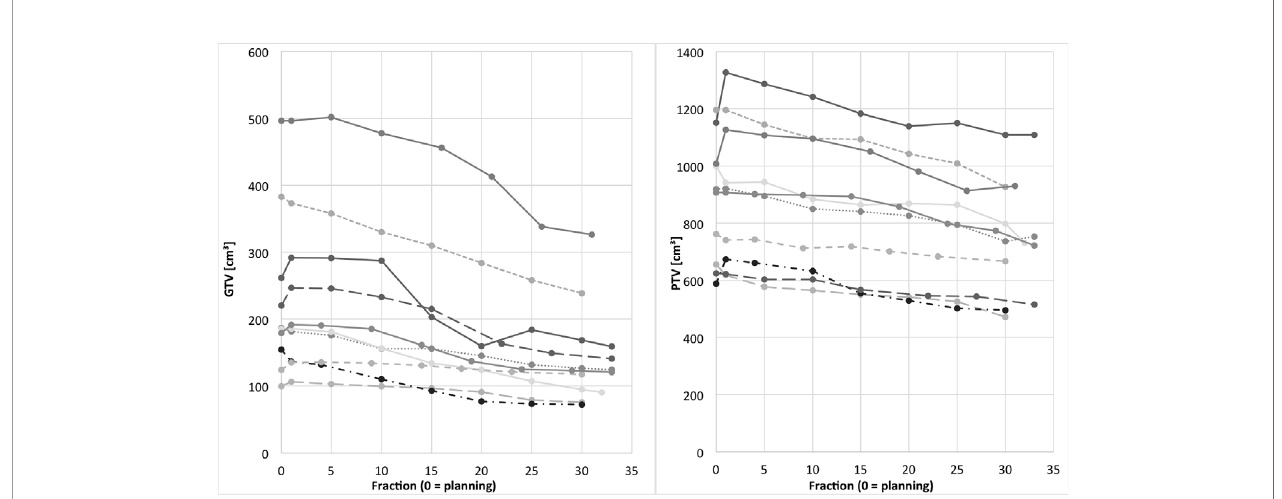
FIGURE 1 | Individual GTV (left) and PTV (right) over the course of radiotherapy for all patients (fraction 0 = planning). GTV and PTV of the same individual patients are represented by the same line type.